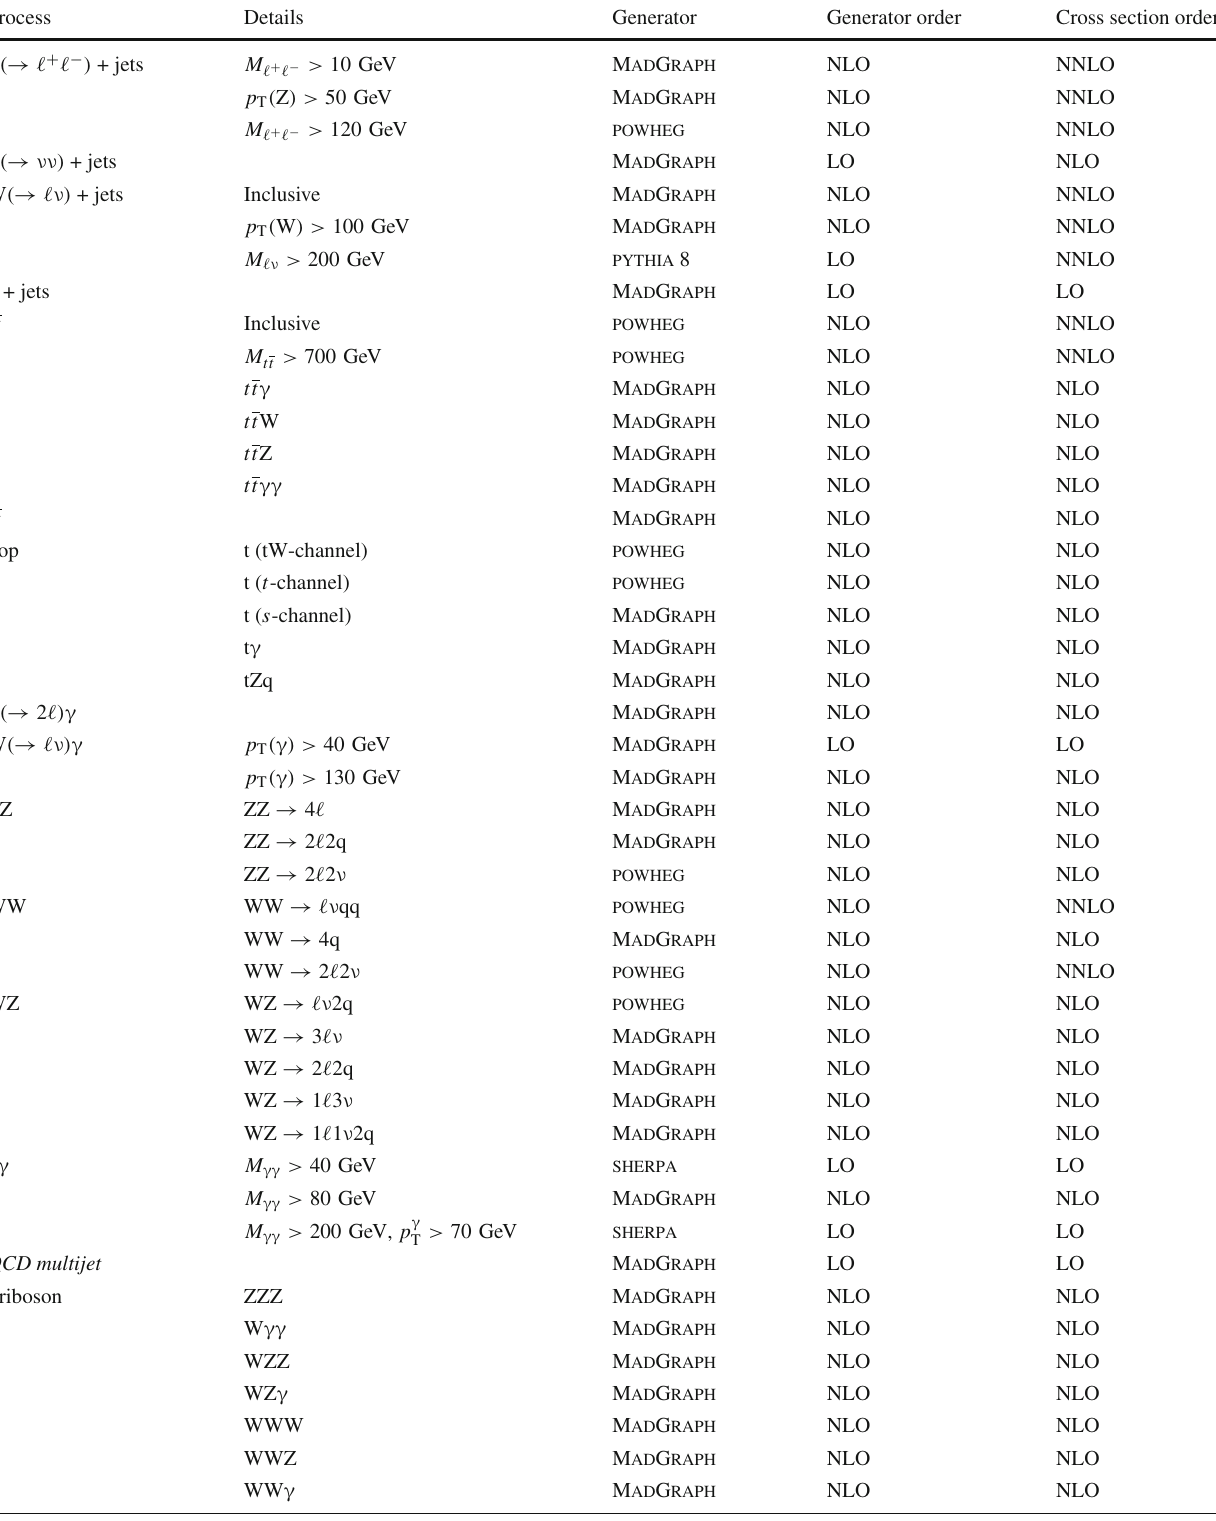
Table 1 Summary of standard model simulated samples. The generator described in the table corresponds to the matrix element generator Process Details Generator Generator order Cross section